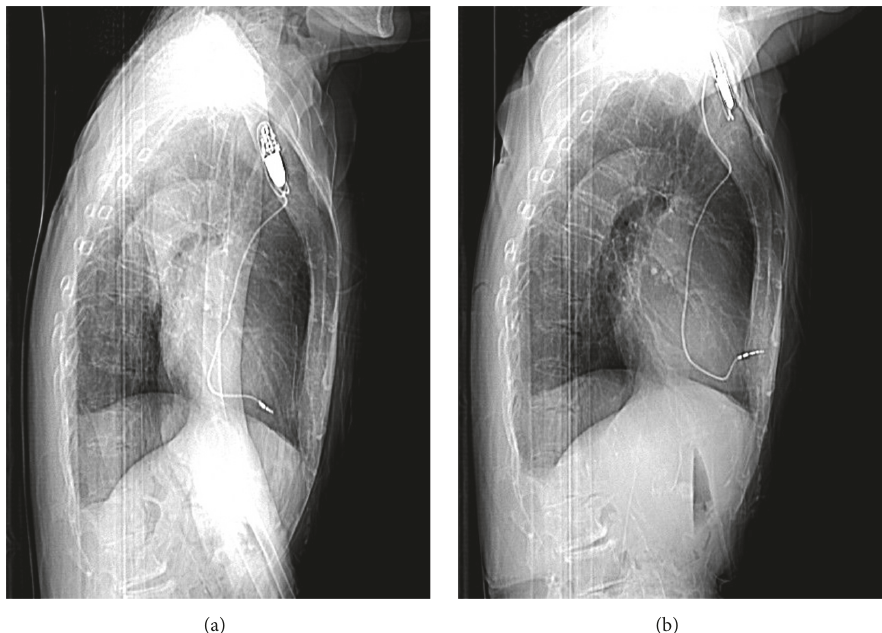
Figure 1: Lateral chest X-ray film demonstrating the position of the lead. (a) Just after the surgery. The tip of the lead was in the correct position. (b) Four days after the surgery. The tip of the lead intruded into the chest wall.